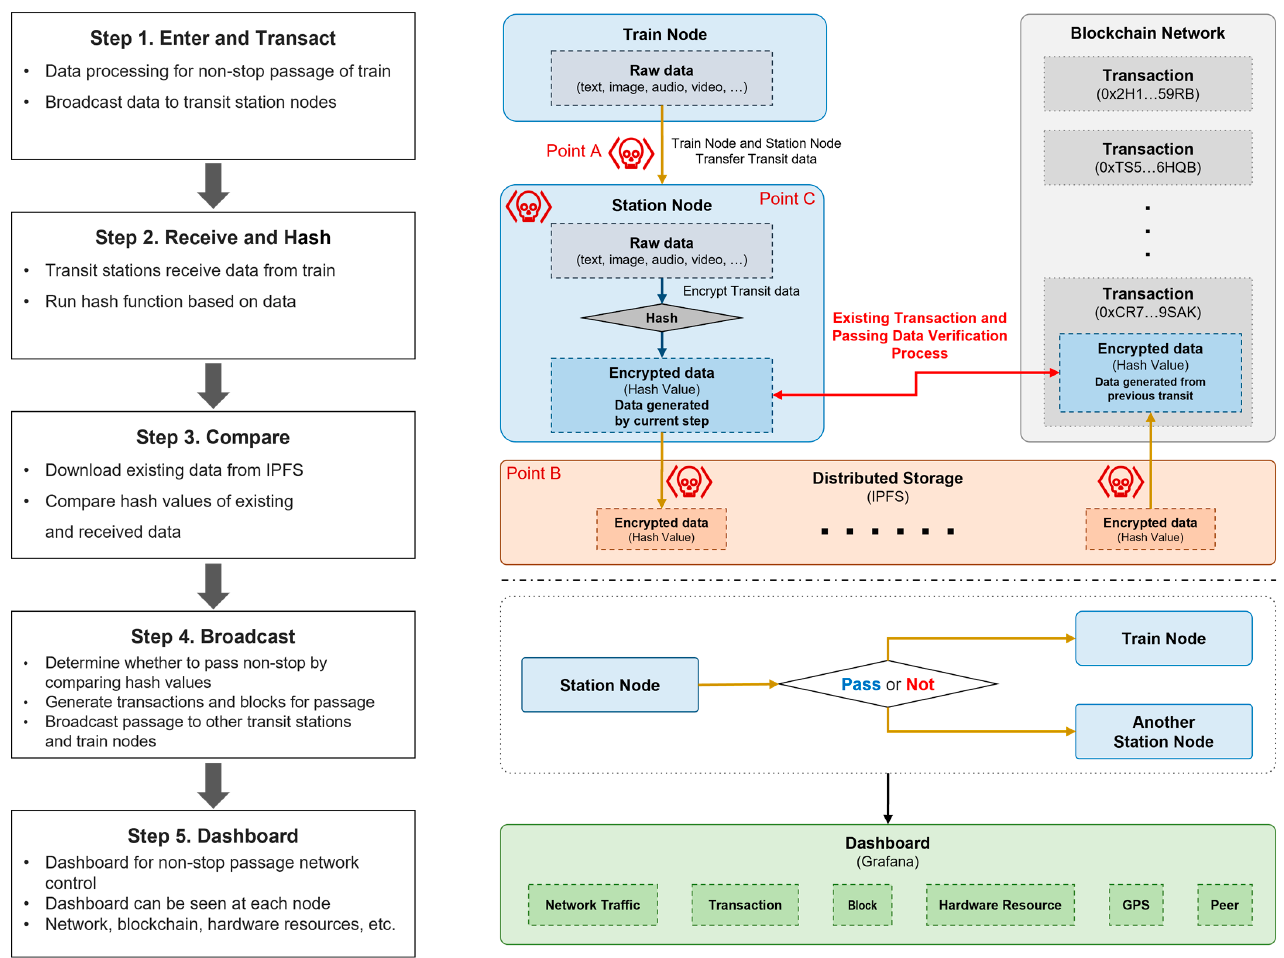
Figure 2. Process overview of non-stop customs clearance system and attack points.